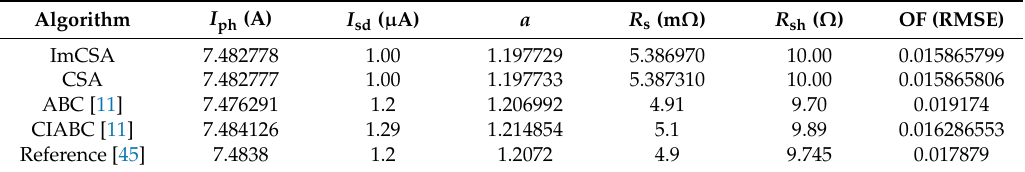
Table 11. Comparison among various parameter estimation algorithms for the PMM of polycrystalline STP6-120/36